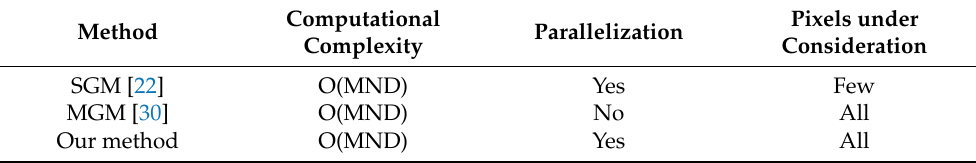
Table 1. Comparison of SGM, MGM and our Omni-directional